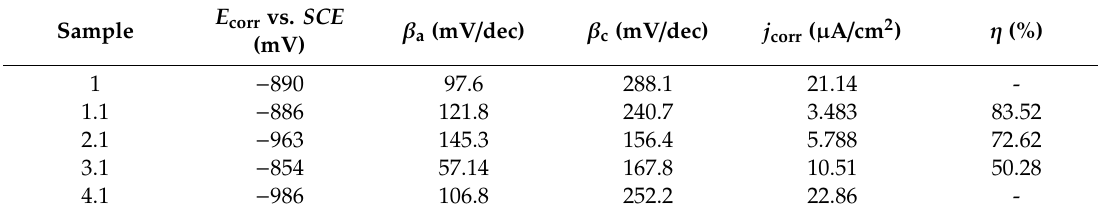
Table 3. Polarization test results in fresh water, at a temperature (23 ± 2) ◦ C, with and without inhibitor. Sample